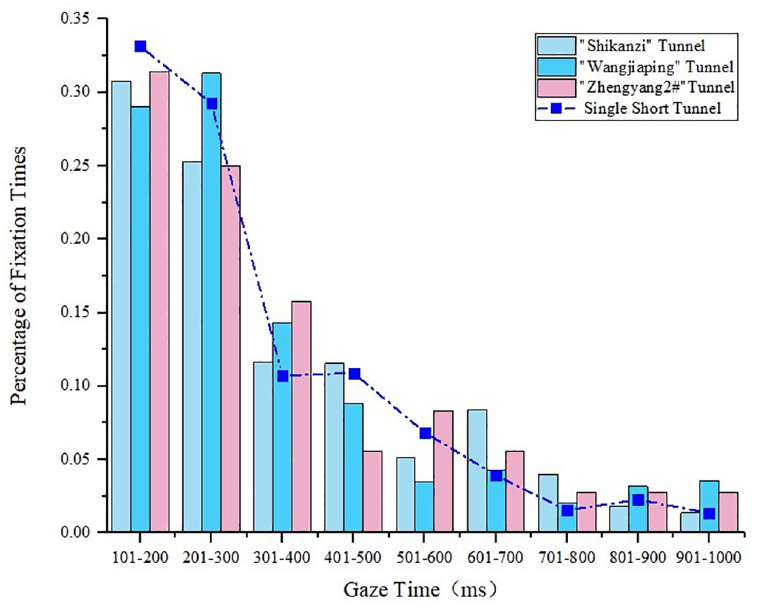
Fig 3. Statistical diagram of the gaze time of the short tunnels in the tunnel